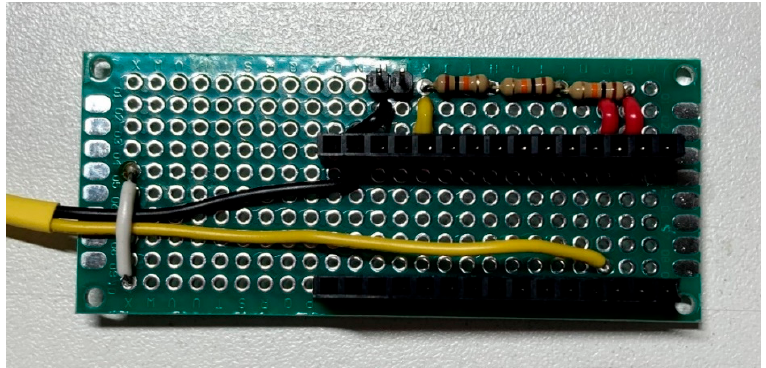
Figure 9. The completed circuit is wired to connect to a relay and measure a single thermistor. With the circuit fully constructed, the dryer firmware (available on the OSF repository [45]) was uploaded to an Arduino Nano, which was then installed in the female header pins with the USB on the column ‘A’ side of the board (Figure 10a). The thermistor was attached to its male header pins and the relay was connected to the signal wires (Figure 10b).